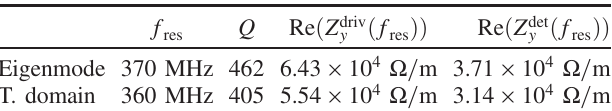
TABLE I. The driving and the detuning impedances of the roman pot cavity, calculated with the eigenmode method and with the time-domain wakefield